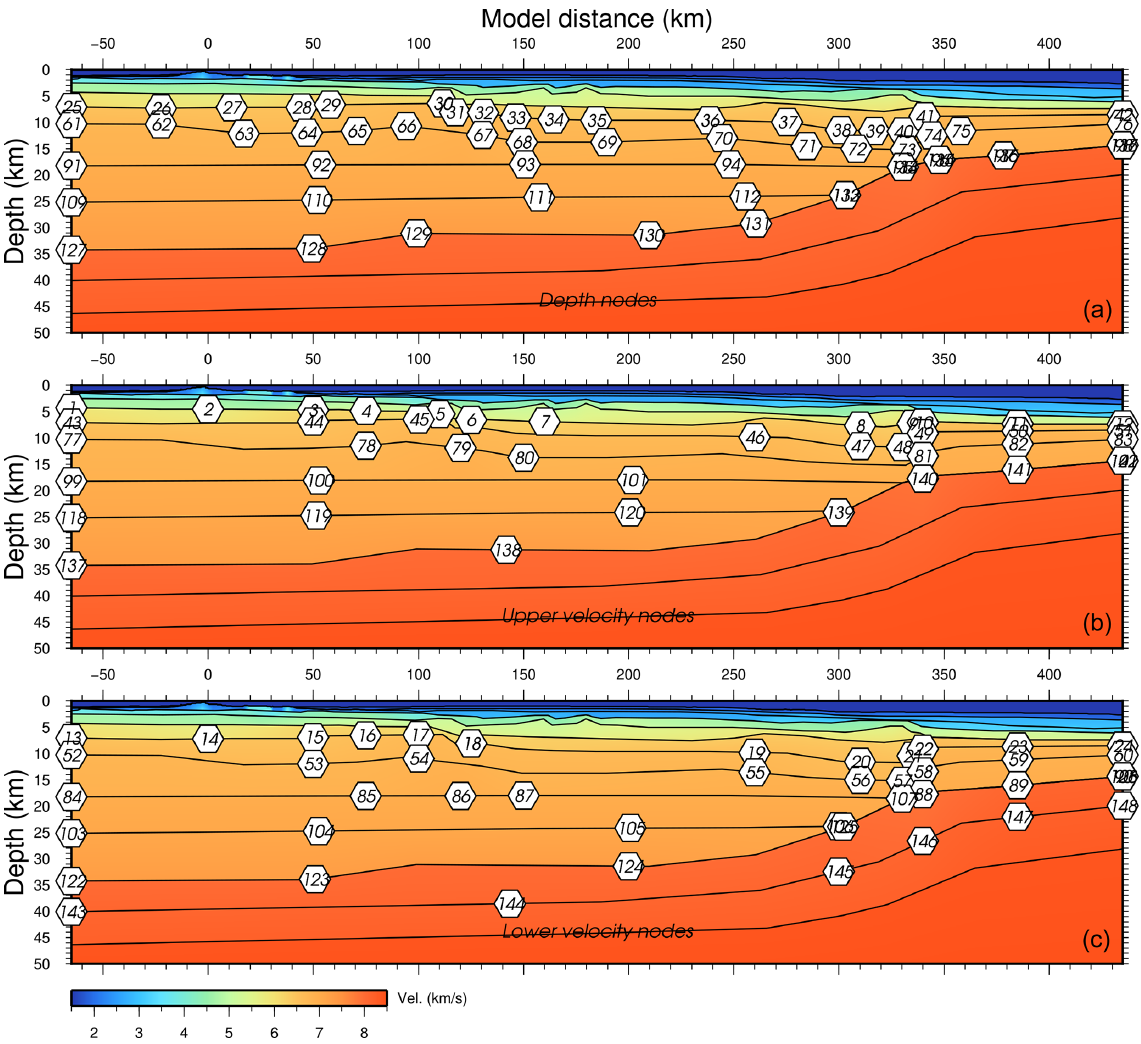
Figure B1. MZ3 final velocity model with parameter selection (white hexagons) for VMONTECARLO. The top panel shows depth param- eters, the middle panel shows the top of the layer velocity parameters and the bottom panel shows the base of the layer velocity parameters. Interfaces are indicated by black